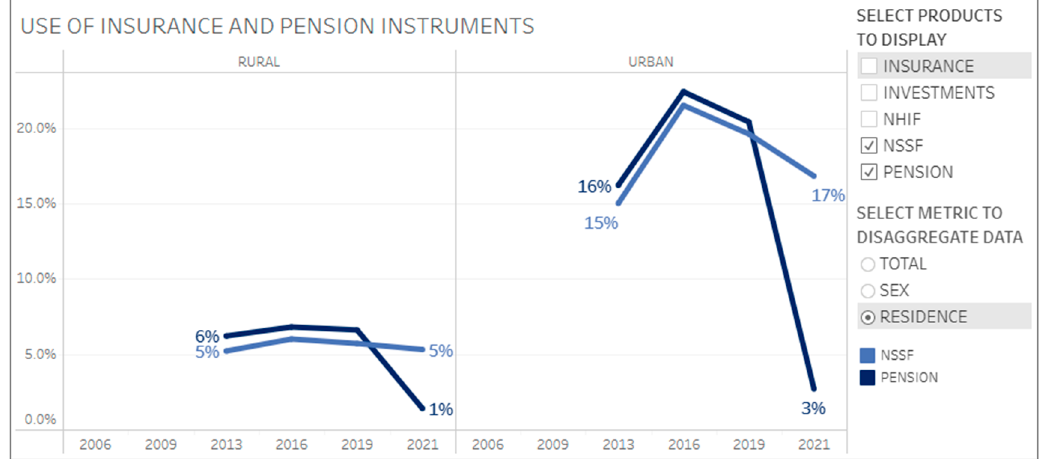
Figure A3. NSSF and other pension uptake by residence. Source: FinAccess Kenya (2022).